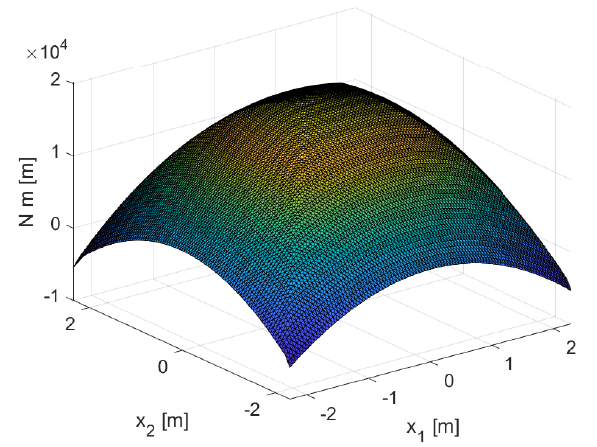
Figure 17. Optimized stress